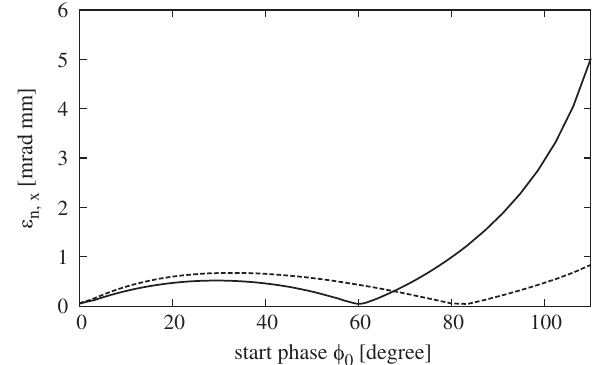
FIG. 11. rf-induced emittance growth at the exit of a half-cell rf gun cavity operating at 1.3 GHz, E 0 ¼ 50 MV = m, x ¼ 0 . 0 mm, σ ¼ 0 . 75 mm. An initial constant current bunch x off of ϕ m ¼ 4 . 68 ° length has been used in the numerical simulation (solid line). The resulting bunch length at the exit of the cavity has been fed into the analytical calculation (dashed line), while a constant transverse beam size equal to the value at the cathode is